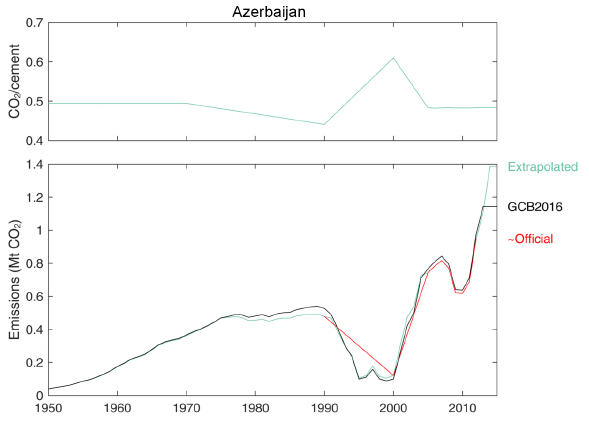
Figure C13. Revised cement emissions for